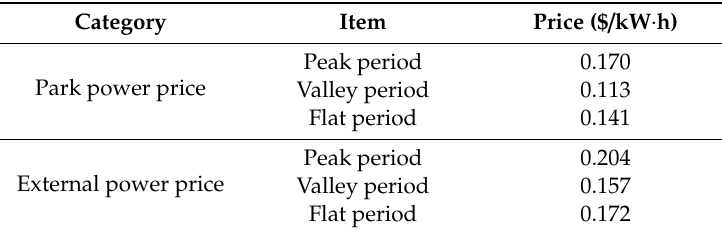
Table 4. Price data.